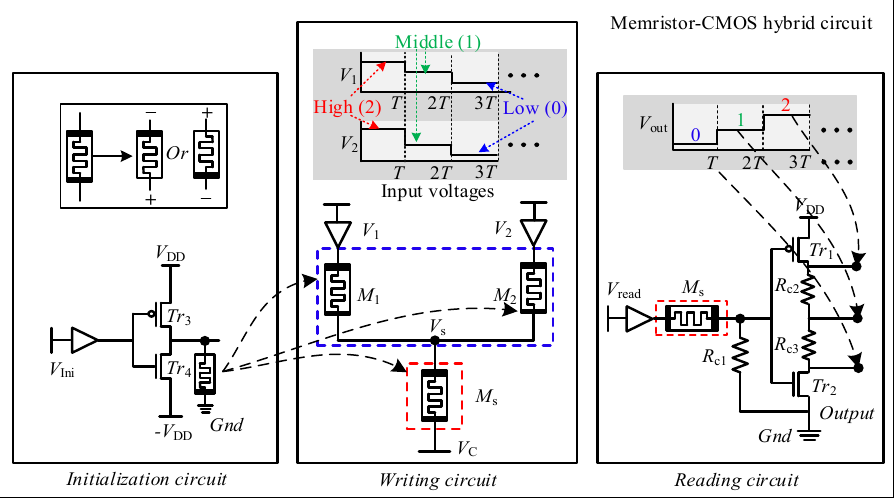
Figure 3. The memristor-CMOS (complementary metal-oxide semiconductor) hybrid logic circuit (including initialization circuit, writing circuit, and reading circuit).